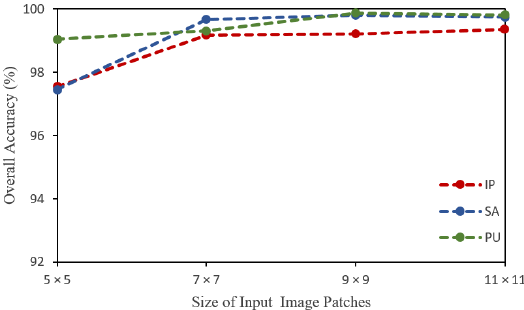
Figure 10. Overall accuracy (%) along with varying sizes of input image patches on IP, SA, and PU datasets.